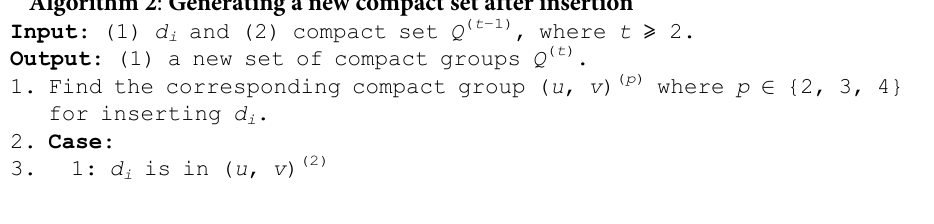
Algorithm 2 : Generating a new compact set after insertion